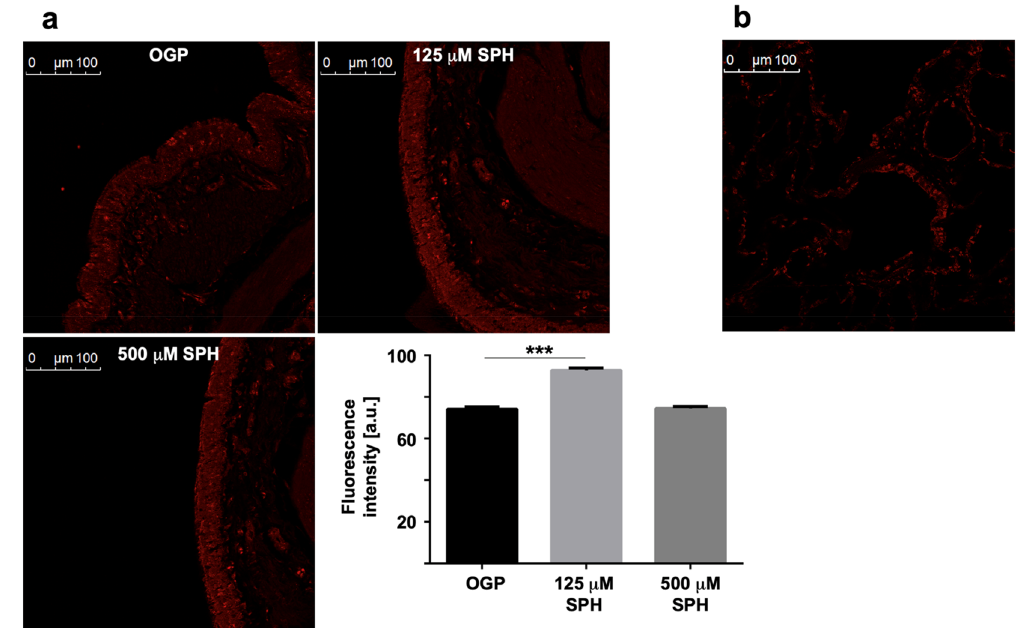
Figure 2. ( a , b ) Fluorescence intensity after staining with Cy3-coupled anti-ceramide ( a ) antibodies and autofluorescence intensity without staining as control ( b ). EVLP minipig lungs were inhaled with sphingosine at concentrations of 125 µM sphingosine (SPH), 500 µM sphingosine (SPH) and with 0.125% octylglucopyranoside (OGP) as control. The lungs were subjected to bronchoscopy 30 and 150 min after